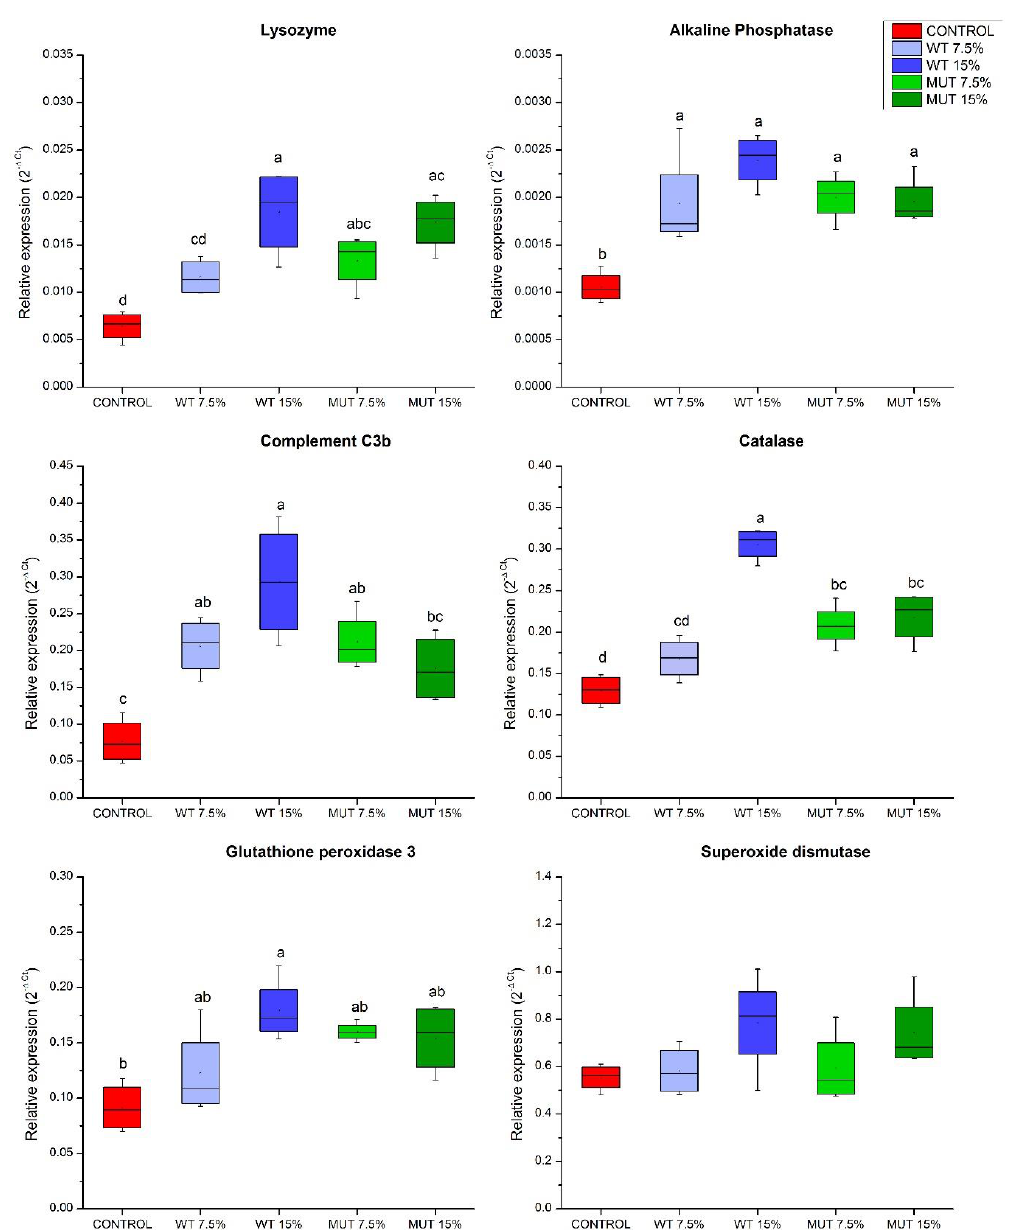
Figure 3. Expression of immune and antioxidant defense genes in the gut of zebrafish fed diets supplemented with Lobosphaera incisa wild type (WT) and mutant strain (MUT). Values in box plots show relative gene-expression levels normalized to EF1α and expressed as 2 −Δ C t ( n = 4 biological replicates, each replicate is a pool of five fish). Different lowercase letters denote significant differences ( p < 0.05) between treatments.